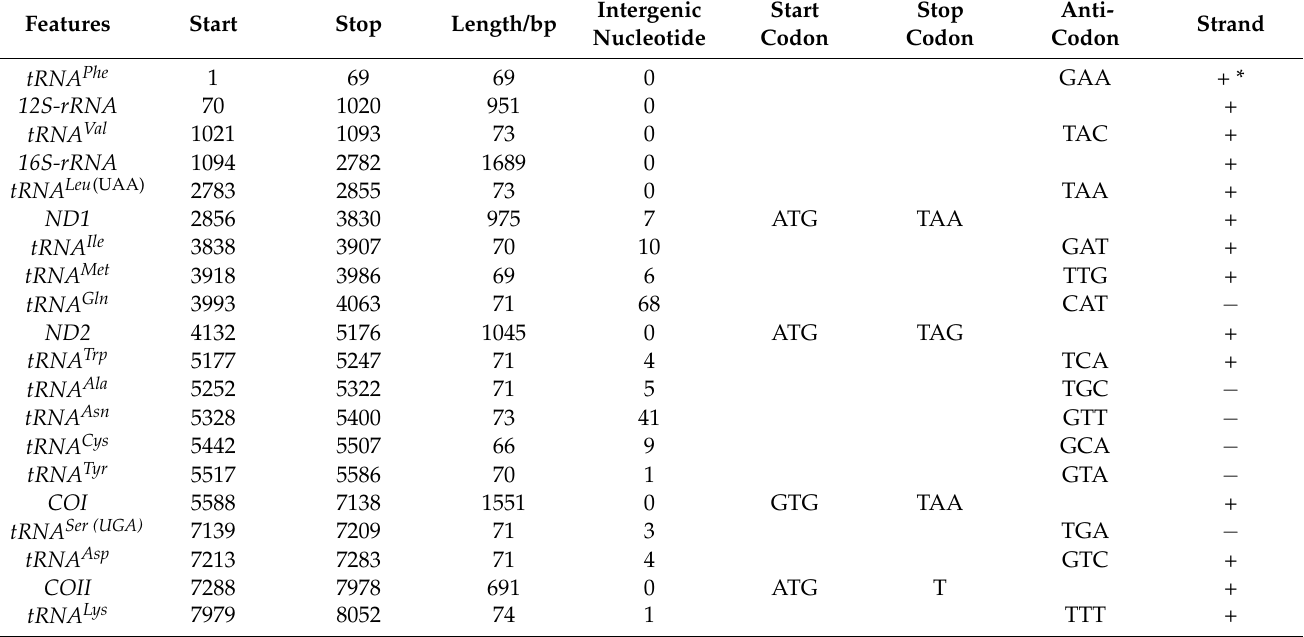
Table 1. Features of the mitochondrial genome of the parrotfishes. Calotomus carolinus was taken as an